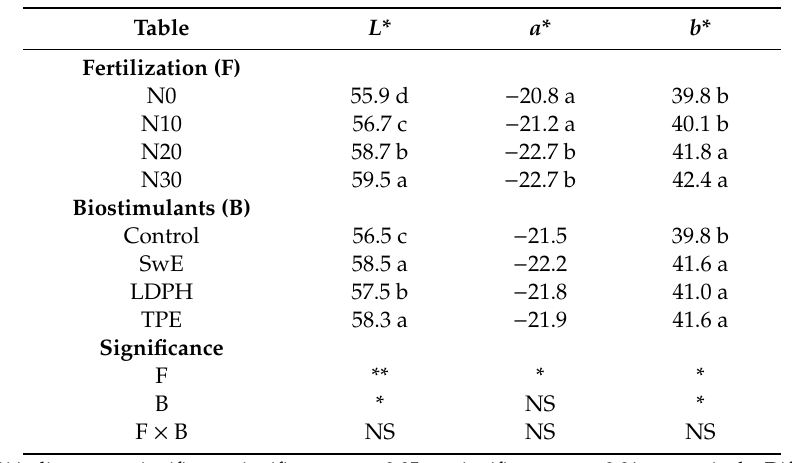
Table 3. E ff ects of nitrogen (N) fertilization levels (0, 10, 20 and 30 kg N · ha − 1 ; N0, N10, N20 and N30, respectively) and biostimulant applications (untreated control, SwE: Extract of seaweed Ecklonia maxima , LDPH: Legume-derived protein hydrolysate and TPE: Tropical plant extract) on leaf hunter color parameters of baby lettuce